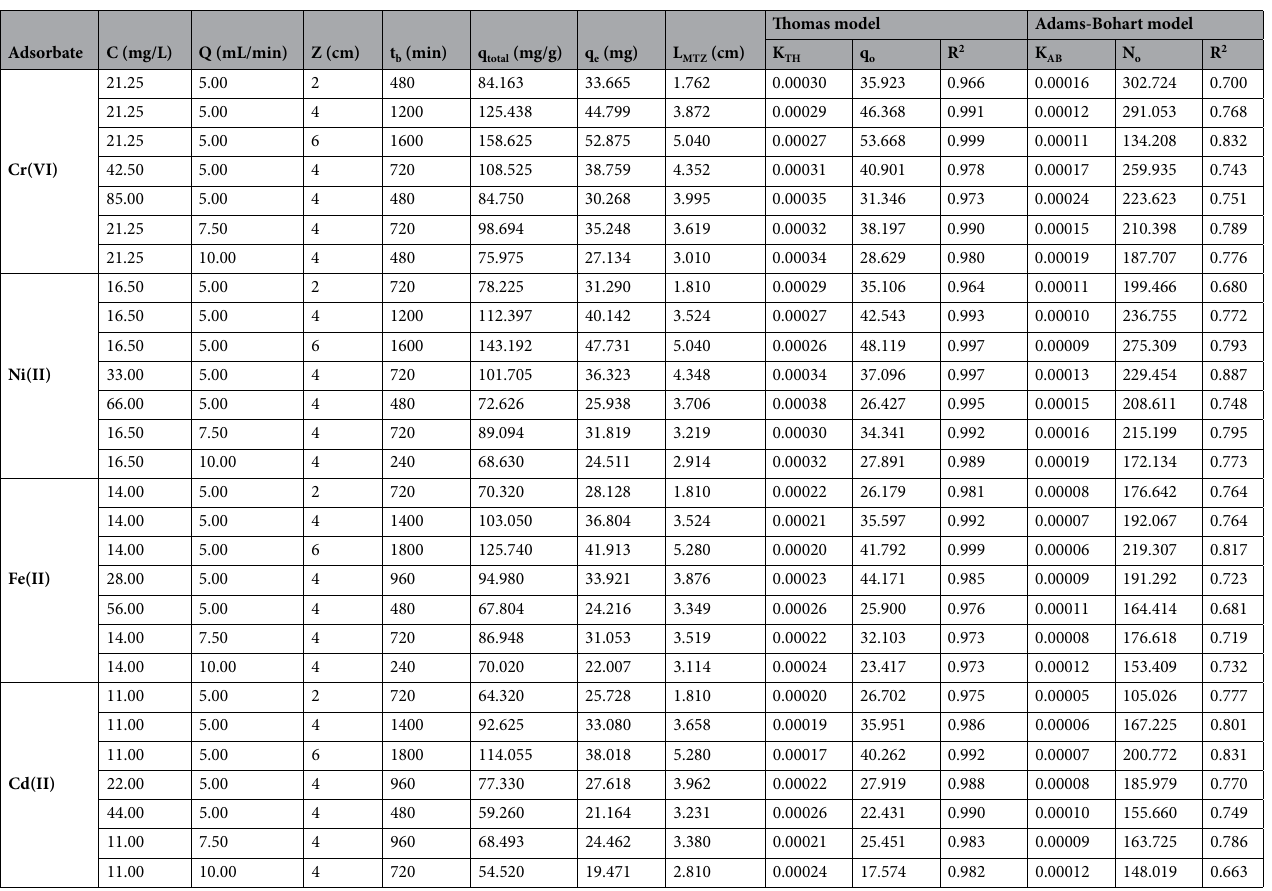
Table 7. Determined parameters of breakthrough curves and continuous adsorption models for Cr(VI), Ni(II), Fe(II) and Cd(II) adsorption by